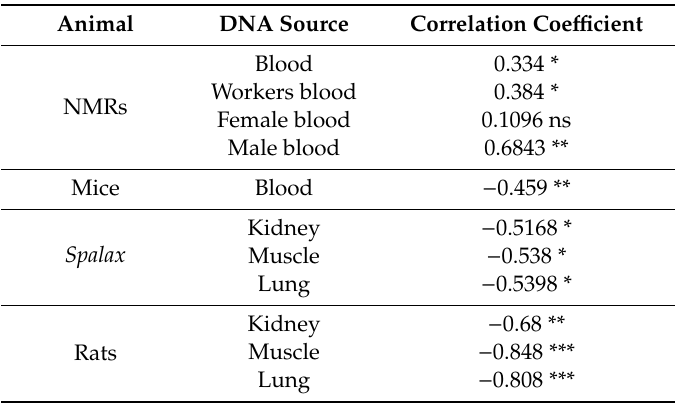
Table 2. Telomere length correlation with